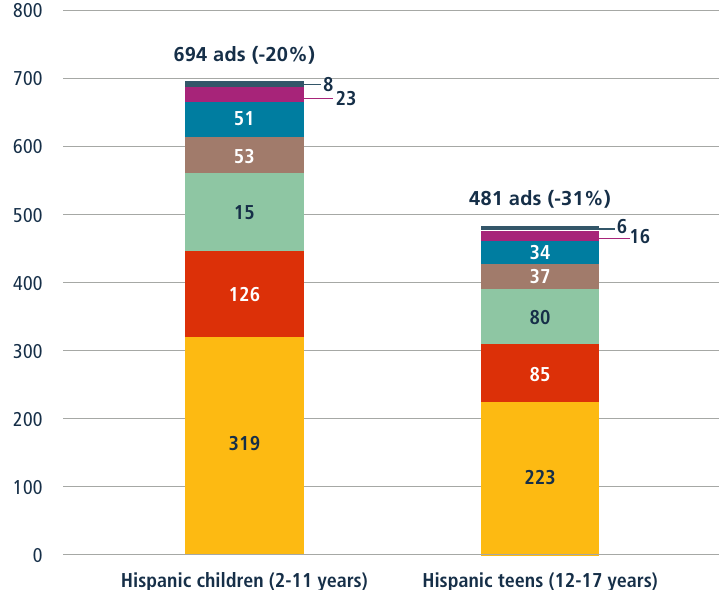
FIGURE 16. HISPANIC YOUTH EXPOSURE TO ADS ON SPANISH-LANGUAGE TV BY